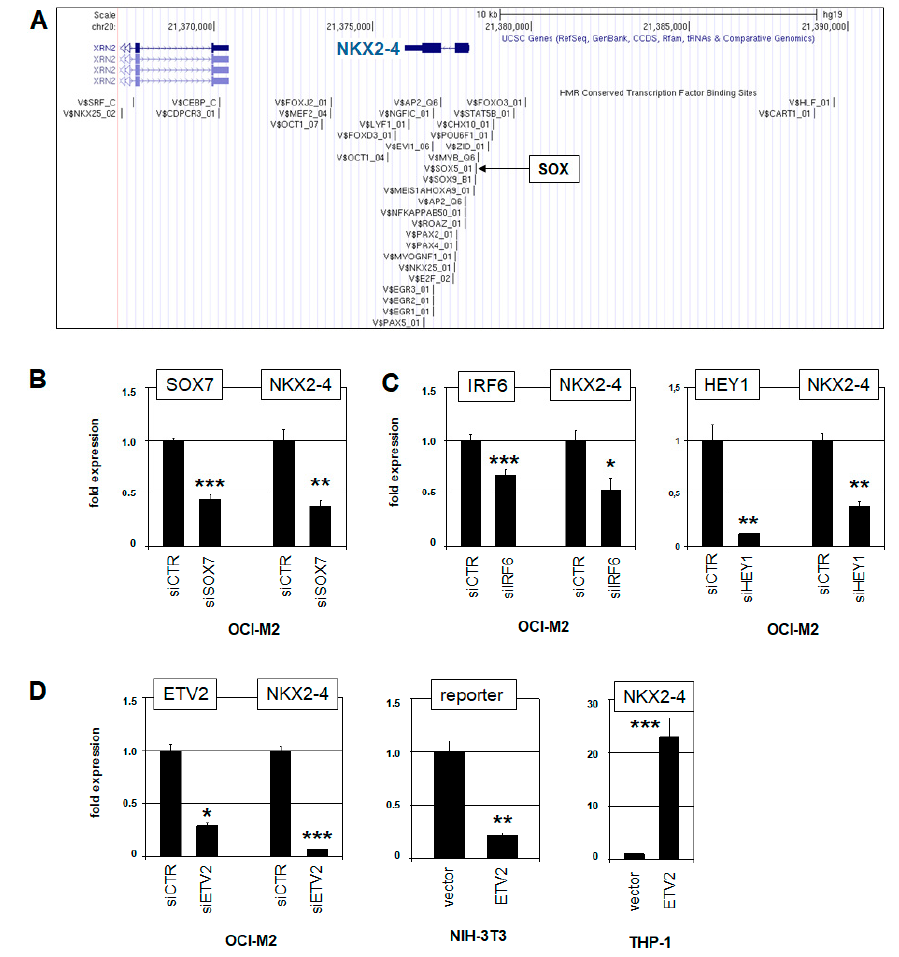
Figure 4. Endothelial TFs activate NKX2-4 in OCI-M2. ( A ) TF binding sites at the NKX2-4 locus were obtained from the UCSC genome browser. A consensus binding site for SOX factors is indicated. ( B ) RQ-PCR analysis of OCI-M2 after siRNA-mediated knockdown of SOX7 shows concomitantly reduced transcript levels of NKX2-4 . ( C ) RQ-PCR analyses of OCI-M2 after siRNA-mediated knock- down of IRF6 ( left ) and HEY1 ( right ) show concomitantly reduced transcript levels of NKX2-4 . ( D ) RQ-PCR analysis of OCI-M2 after siRNA-mediated knockdown of ETV2 shows concomitantly reduced transcript levels of NKX2-4 ( left ). Reporter gene assay for a potential ETV2 binding site at NKX2-4 was performed in NIH-3T3 cells, showing a suppressive effect. Nevertheless, these context- dependent results may indicate direct regulation of NKX2-4 by ETV2 ( middle ). Forced expression of ETV2 in THP-1 cells resulted in strongly elevated NKX2-4 expression ( right ). Statistical significance was assessed by Student’s t -test (two-tailed), and the calculated p -values are indicated by asterisks (* p < 0.05, ** p < 0.01, *** p < 0.001, n.s. not significant). The expression levels of siCTR-treated and vector-treated cells were set as